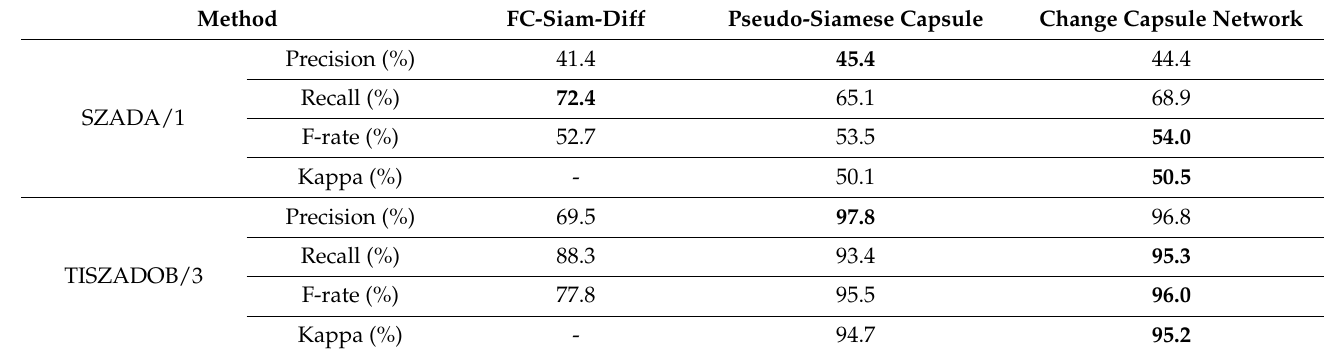
Figure 13. Patch-based change maps generated using different methods on the AUAB dataset. ( a ) Image patch taken in 2009. ( b ) Image patch taken in 2009. ( c ) Ground truth. ( d ) Result using FC-Siam-diff. ( e ) Result using the pseudo-siamese capsule network. ( f ) Result using the change capsule network. Table 7. Experimental results compared with other methods on the SZTAKI dataset.